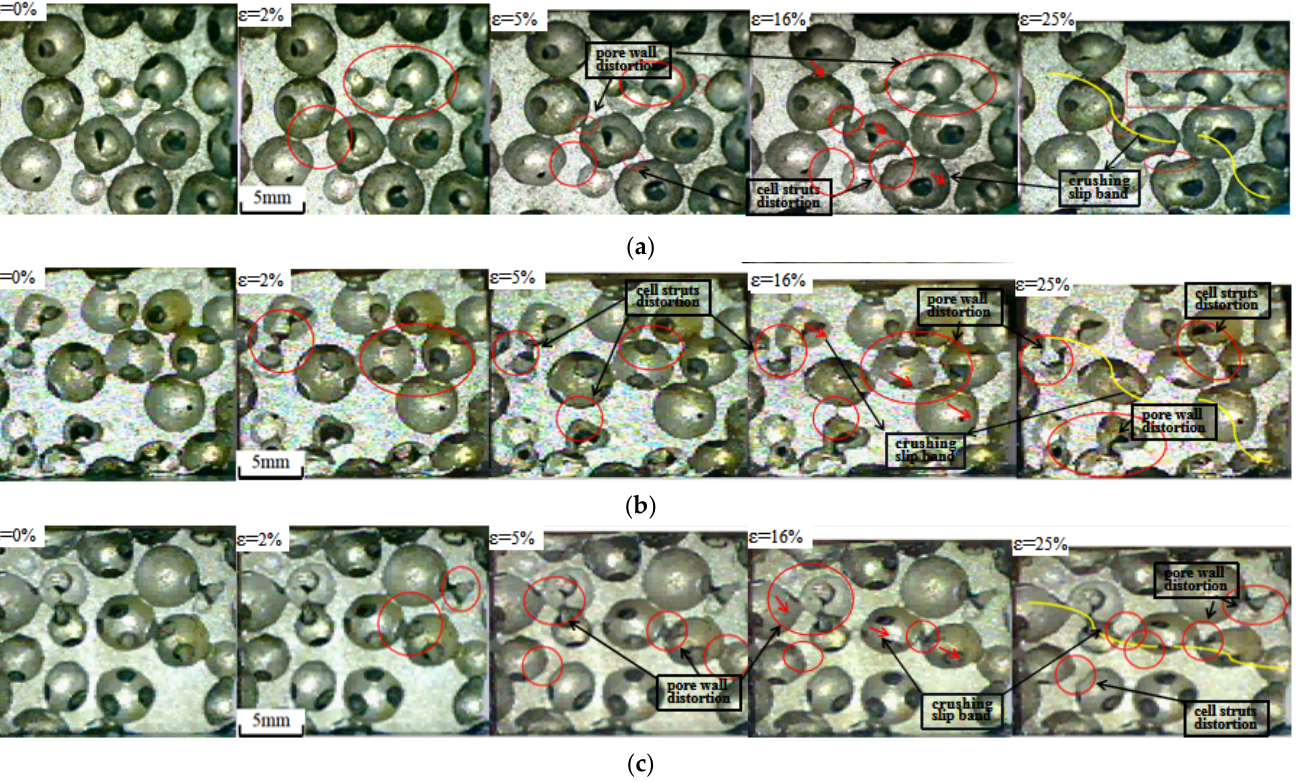
Figure 5. CCD surface images of open-cell aluminum foam under quasi-static compression deformation at different rates: ( a ) 2 mm/min; ( b ) 10 mm/min; ( c ) 50 mm/min.